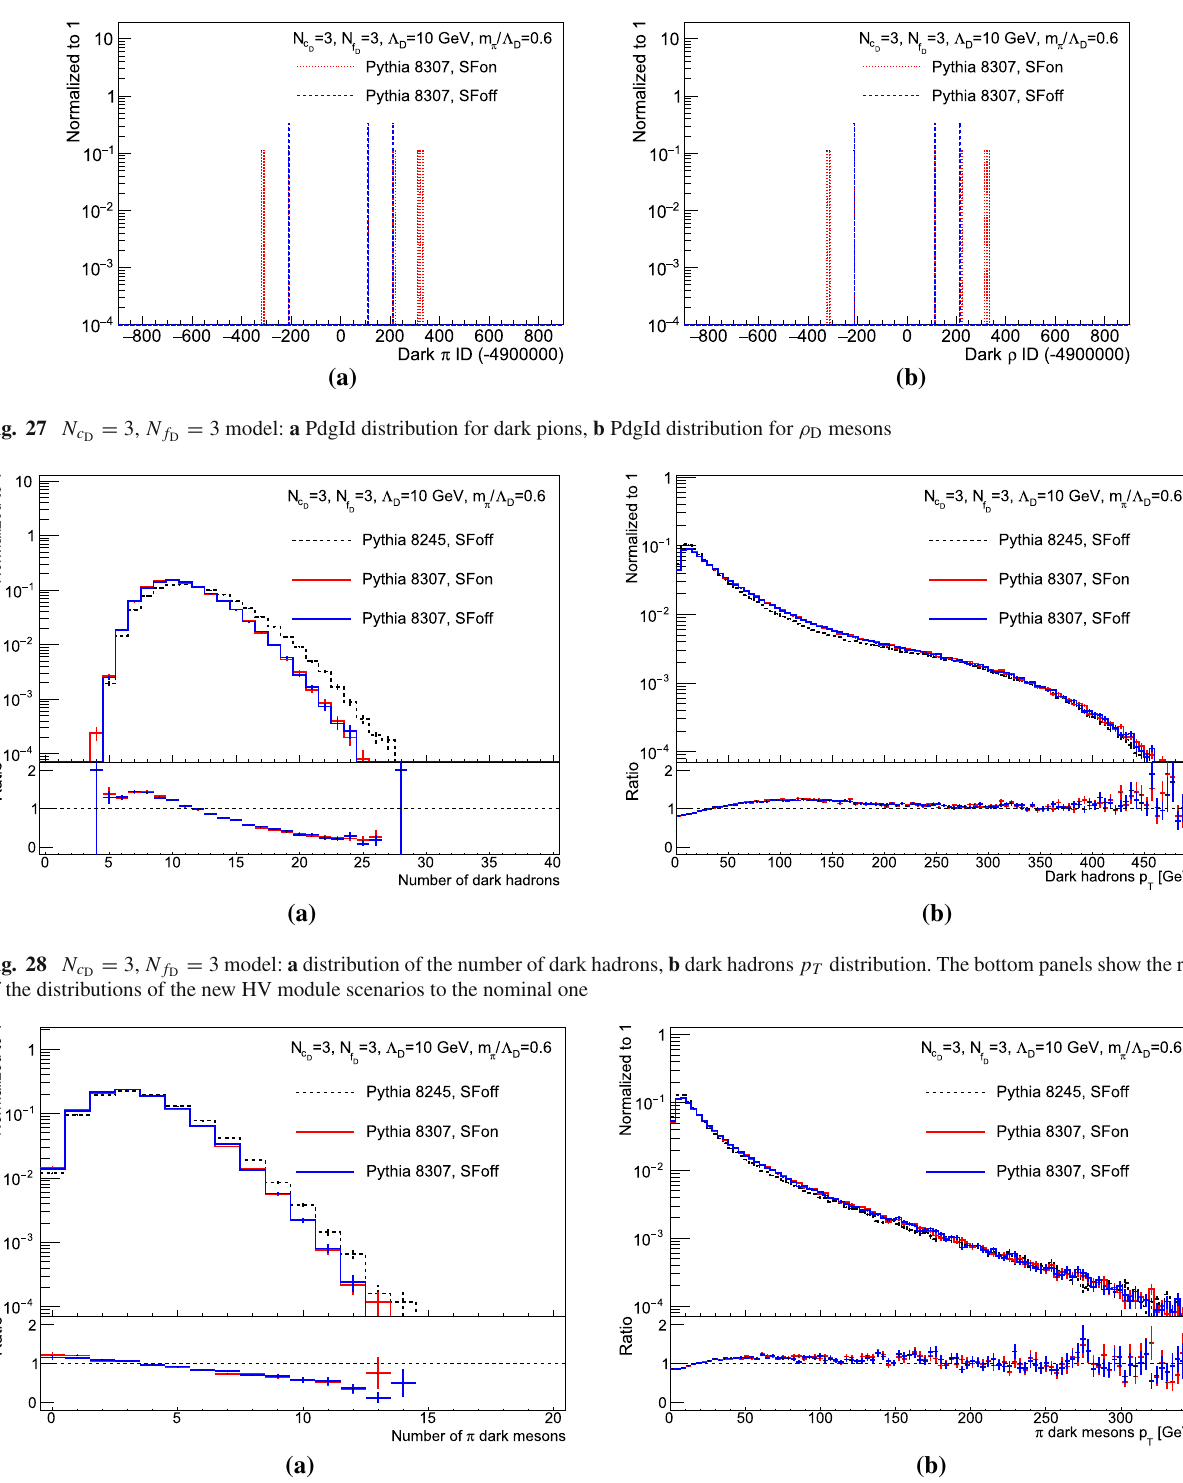
T distribution. The bottom panels show the ratio of